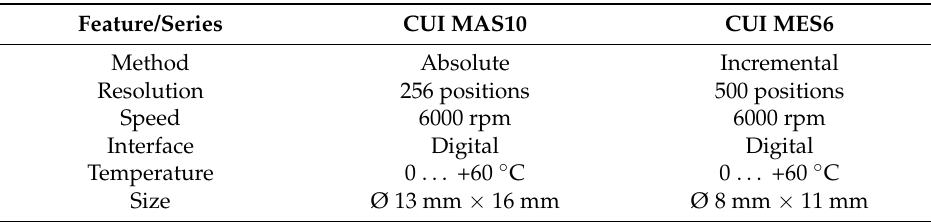
Table 1. Examples of high-end state-of-the-art